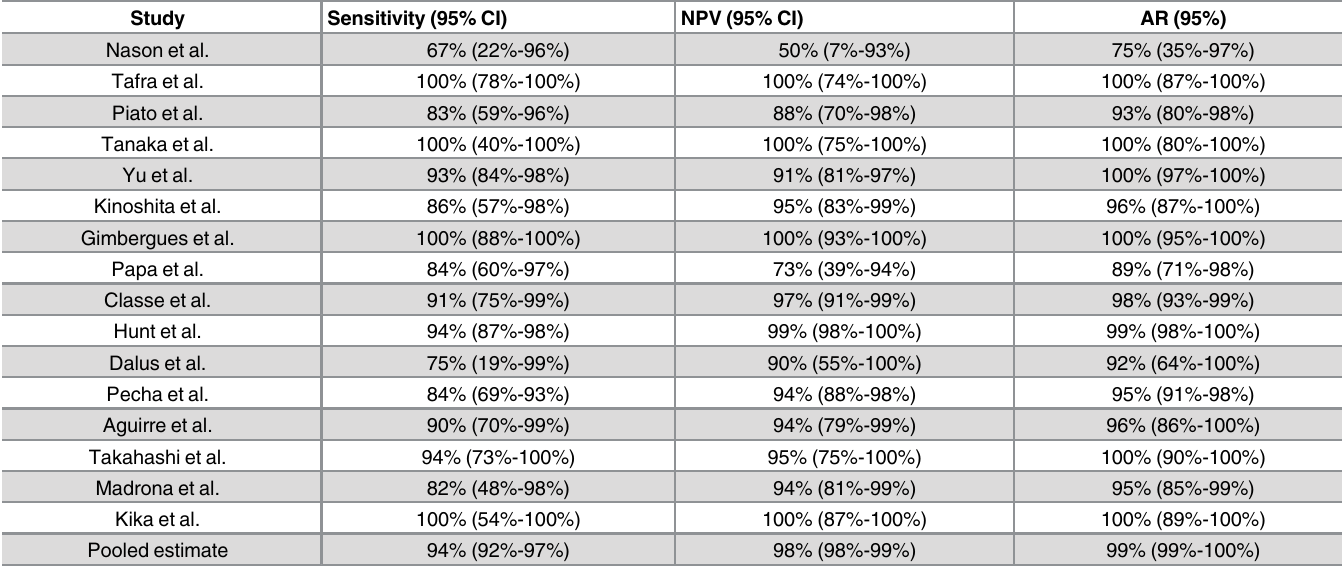
Table 5. Sensitivity, NPV and AR in individual studies.